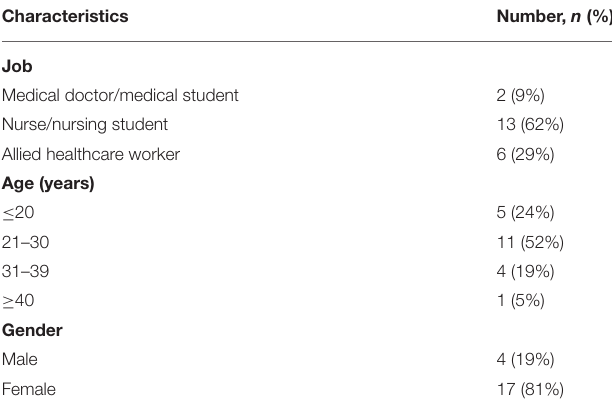
TABLE 2 | Demographics of